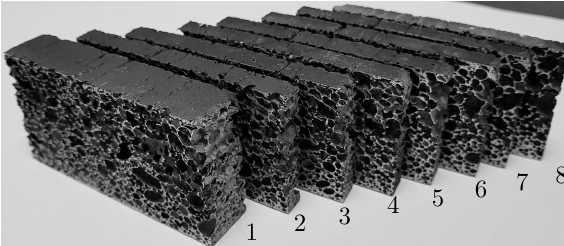
Figure 6. Photo image of the produced aluminum foam [11] cut into 8 samples designated for scan- ning (Fig. 7) and other experiments.